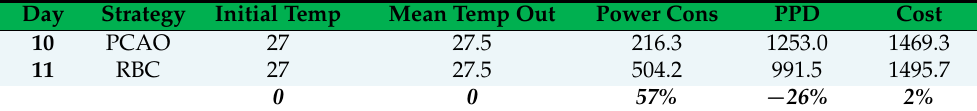
Table 7. Comparison between the PCAO (10th) and RBC (11th) summer days.